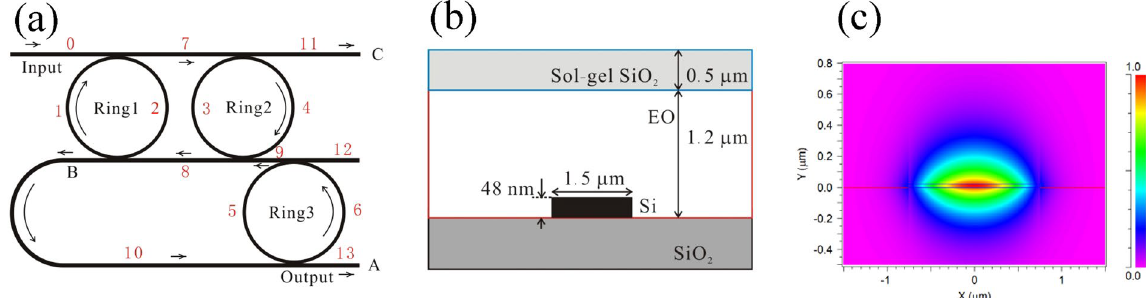
Figure 1. Schematics of the triple-ring resonator modulator. ( a ) Structure of the modulator. ( b ) Cross- section of the waveguide. ( c ) Fundamental TE mode distribution. The lengths of the waveguides are L 0 = L 11 = L 12 = L 13 = 40 µ m, L 1 = L 2 = L 3 = L 4 = 240 µ m, L 5 = L 6 = 120 µ m, L 7 = L 8 = 240 µ m, L 9 = 80 µ m, and L 10 = 400 µ m. The L 1 , L 2 , L 3 and L 4 are chosen to set the resonance close to the wavelength of 1550 nm. The modal overlap integral factor Γ is 0.525.